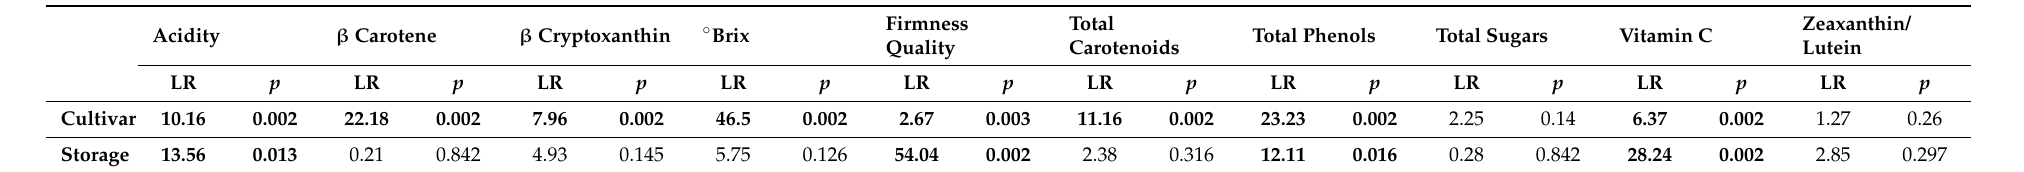
Table 2. Univariate test results from the manylm model regressing cultivar and storage treatment against peach intrinsic quality